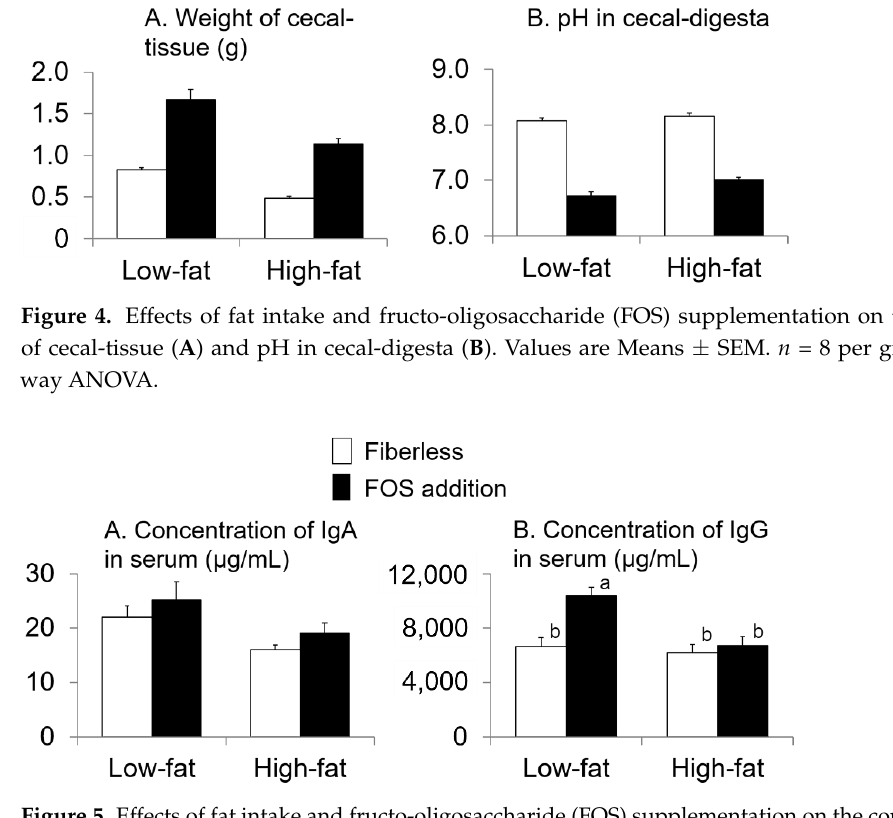
Figure 4. Effects of fat intake and fructo-oligosaccharide (FOS) supplementation on the weight of cecal-tissue ( A ) and pH in cecal-digesta ( B ). Values are Means ± SEM. n = 8 per group. two-way ANOVA.